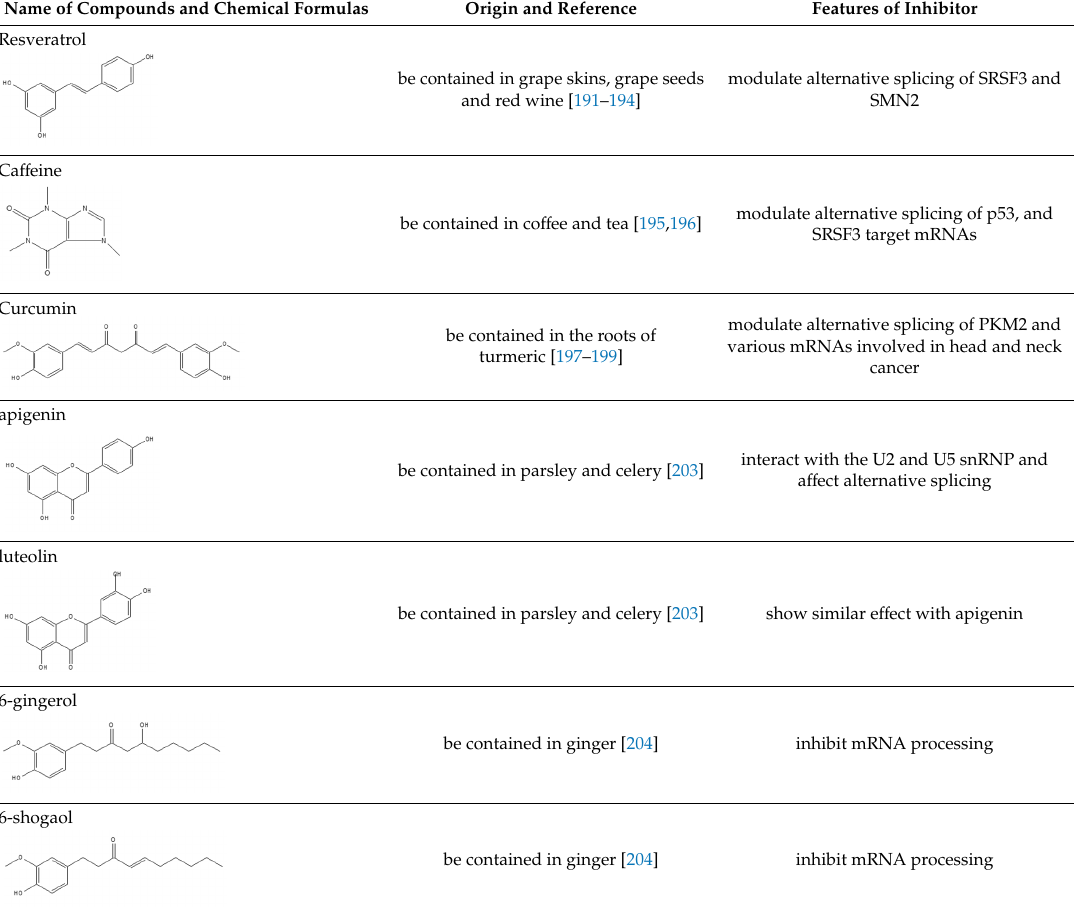
Table 3. Food derived compounds which control mRNA processing or